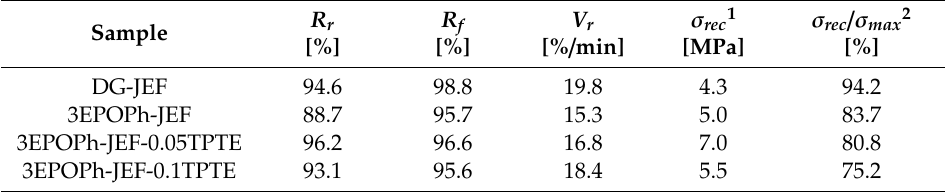
Table 6. Shape-memory properties of the materials